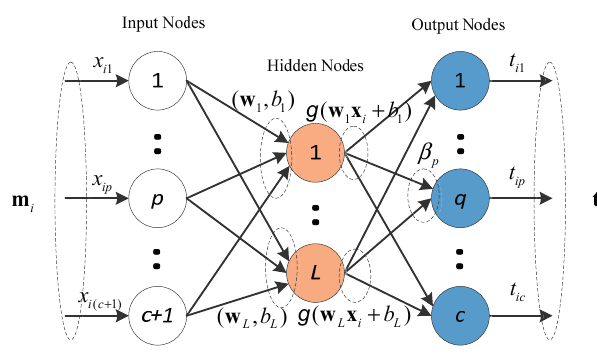
Figure 2. Decision making network of